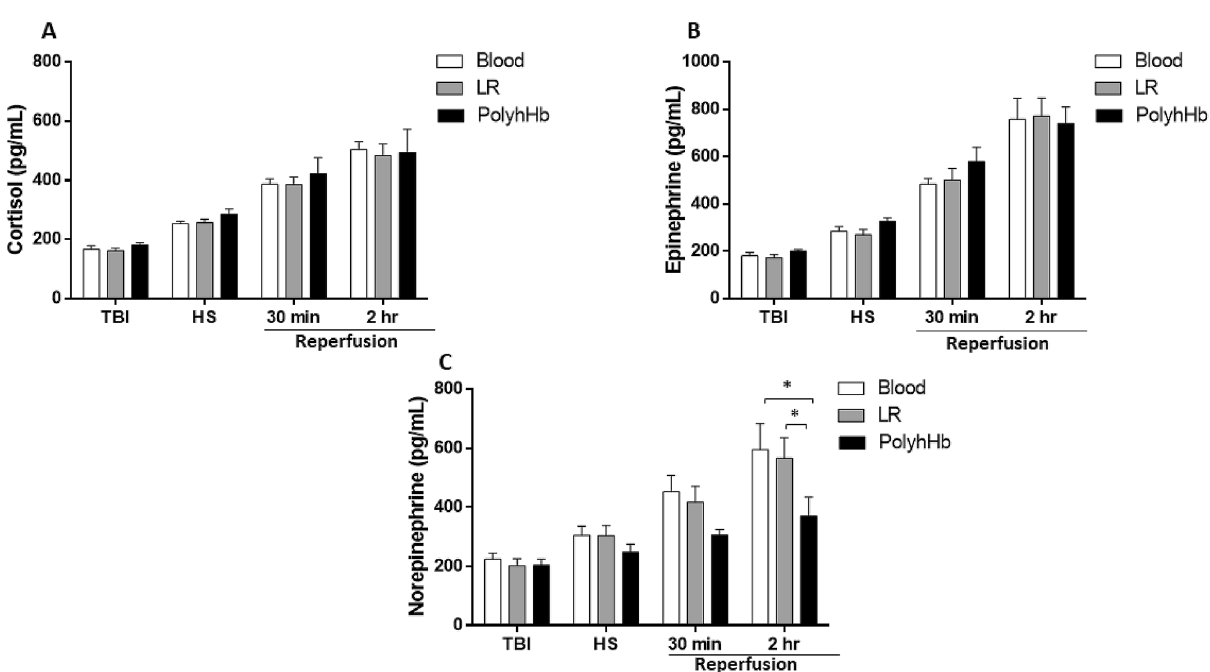
Figure 4. Plasma measurement of cortisol and catecholamines. ( A ) Cortisol; ( B ) epinephrine; ( C ) norepinephrine. At TBI (post traumatic brain injury); HS (hemorrhagic shock); 30 min into resuscitation; 2 h into resuscitation. LR Lactated Ringer’s solution. N =